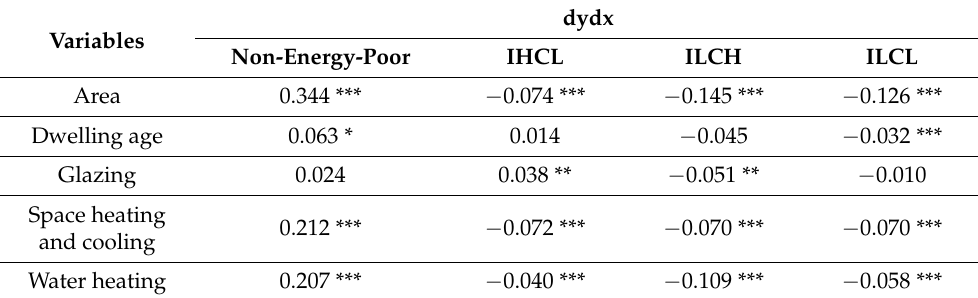
Table 3. Marginal effect.